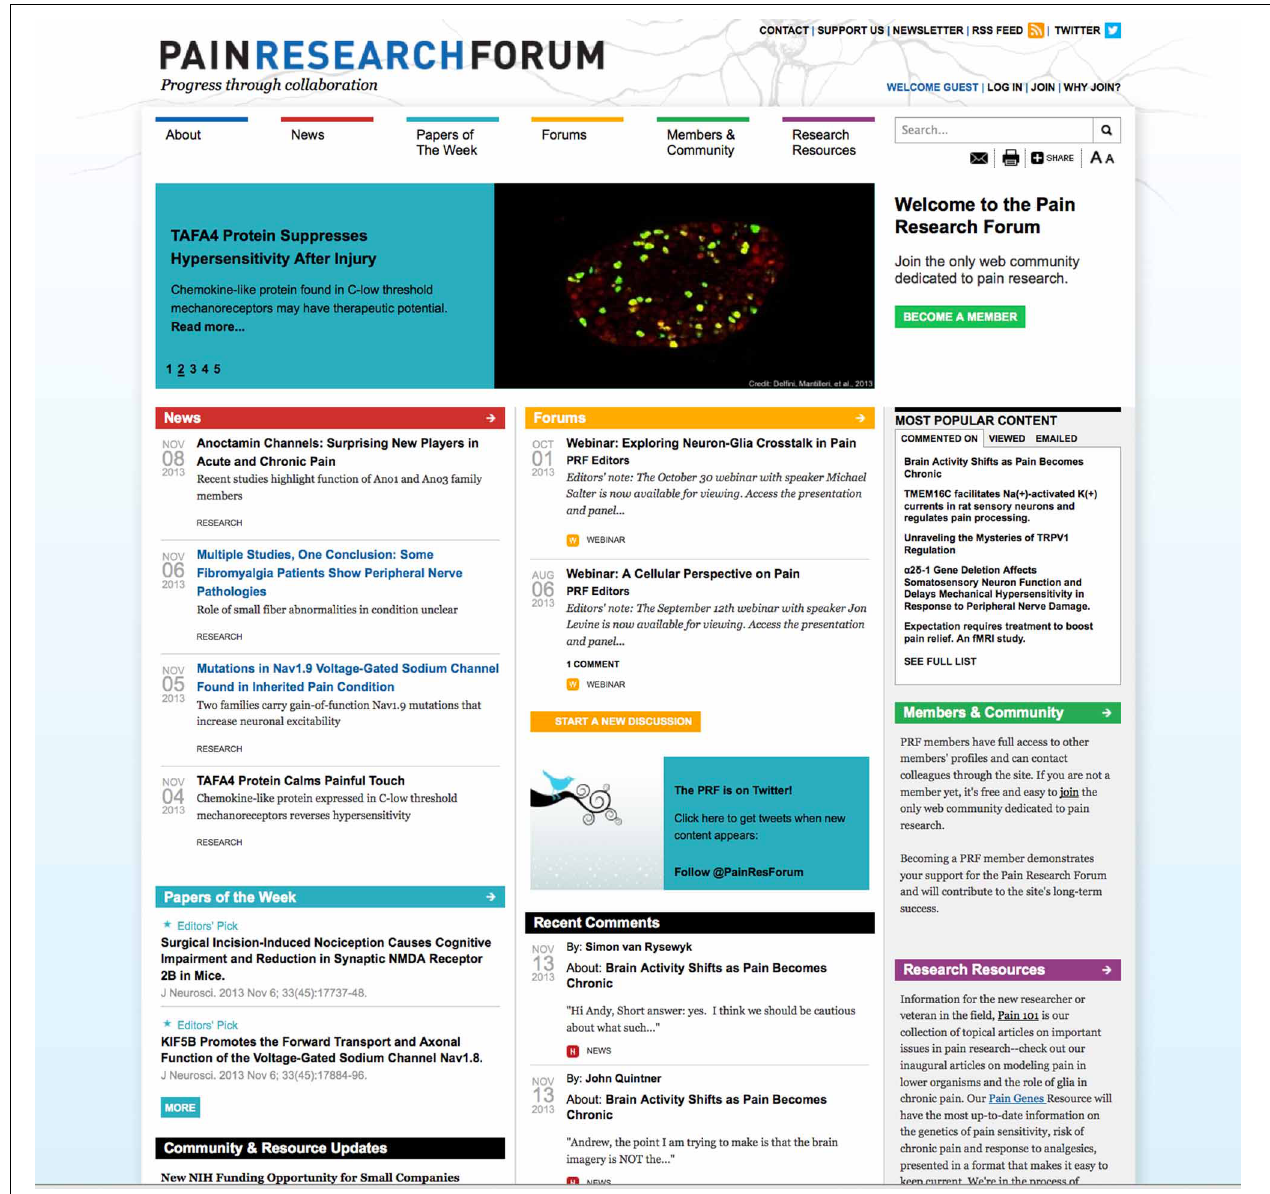
FIGURE 2 | Pain Research Forum. Screenshot of home page for Pain Research Forum (http://www.painresearchforum.org) for anonymous users (not